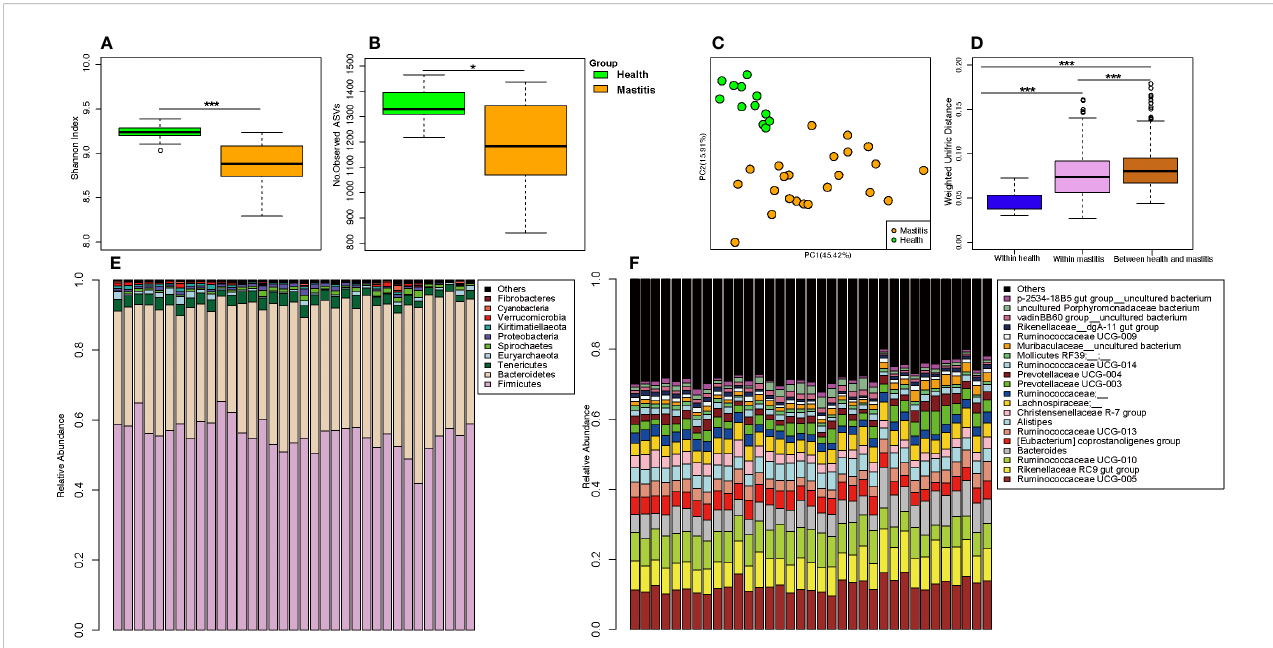
FIGURE 6 Comparison of the composition of gut microbiome between dairy cows with mastitis and healthy cows. (A) Shannon index and (B) Number of observed ASVs of gut microbiotas in dairy cows with mastitis and healthy cows; (C) Principal coordinate analysis (PCoA) based on Weighted Unifrac distance of gut microbiotas in dairy cows with mastitis and healthy cows; (D) Interindividual variations were determined by average weighted UniFrac distances between individuals in gut microbiotas of dairy cows with mastitis and healthy cows, respectively, while between-group variations were determined by distances between cows with mastitis and healthy cows. Stacked bar plots illustrate the mean relative abundance of ASVs at the phylum (E , top 10) and genus (F , top 20) level in the fecal of dairy cows with mastitis and healthy cows. ( ∗ < 0.05, ∗∗∗ < 0.001; p values calculated by Mann – Whitney U in A, B ; p values calculated by the One-way ANOVA test followed by post-hoc Dunn ’ s multiple comparisons test in D